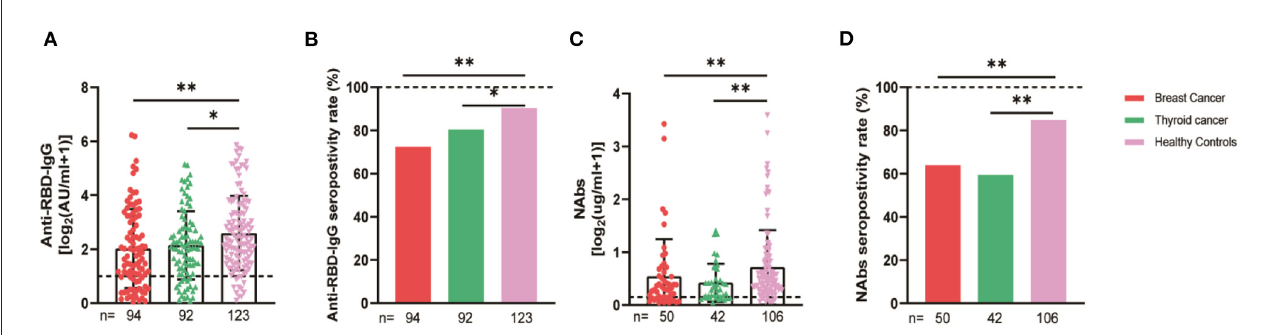
FIGURE6 Antibody response to SARS-CoV-2 vaccine in patients with different cancer. The titers and seropositivity rates of anti-RBD-IgG (A, B) and NAbs (C, D) in the sera of cancer patients were measured. The horizontal dotted lines represent the limit of detection. The error bars represent the median (IQR) (* P < 0.05, ** P < 0.01). NAbs, neutralizing antibodies; IQR, interquartile range; RBD, receptor binding domain.